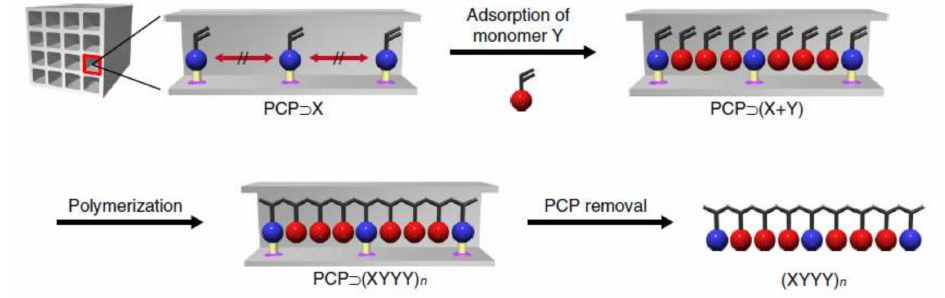
Figure 17. Scheme showing the sequence-regulated radical copolymerization using MOFs [Cu(styrene- 3,5-dicarboxylate)] n [98]. Copyright 2018, Nature Publishing